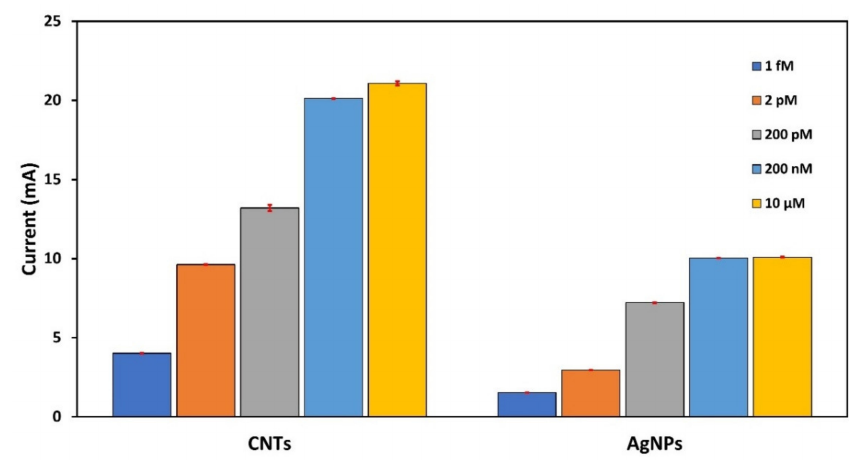
Figure 4. Comparison between CNT-ME / MB-aptamers and AgNP / MB-aptamers at di ff erent concentrations—1 fM, 2 pM, 200 pM, 200 nM, and 10 µ M—of